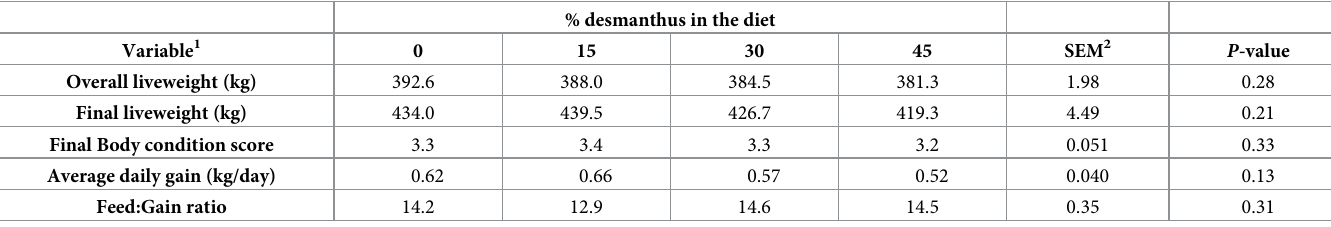
Table 5. Effect of desmanthus proportion on the average liveweight, body condition score, daily gain and feed to gain ratio in supplemented steers. % desmanthus in the diet Variable 1